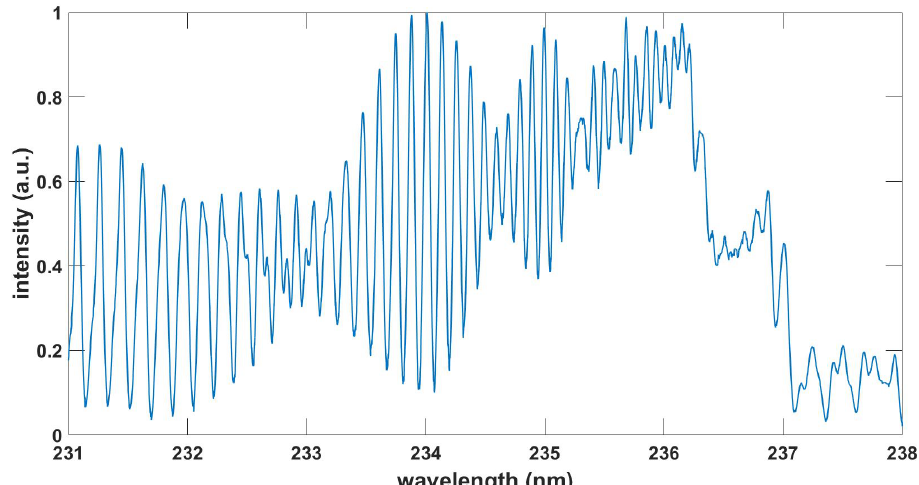
Figure 7. Computed NO gamma spectrum, ∆ v = − 1, δ λ = 0.056nm, T = 6.80